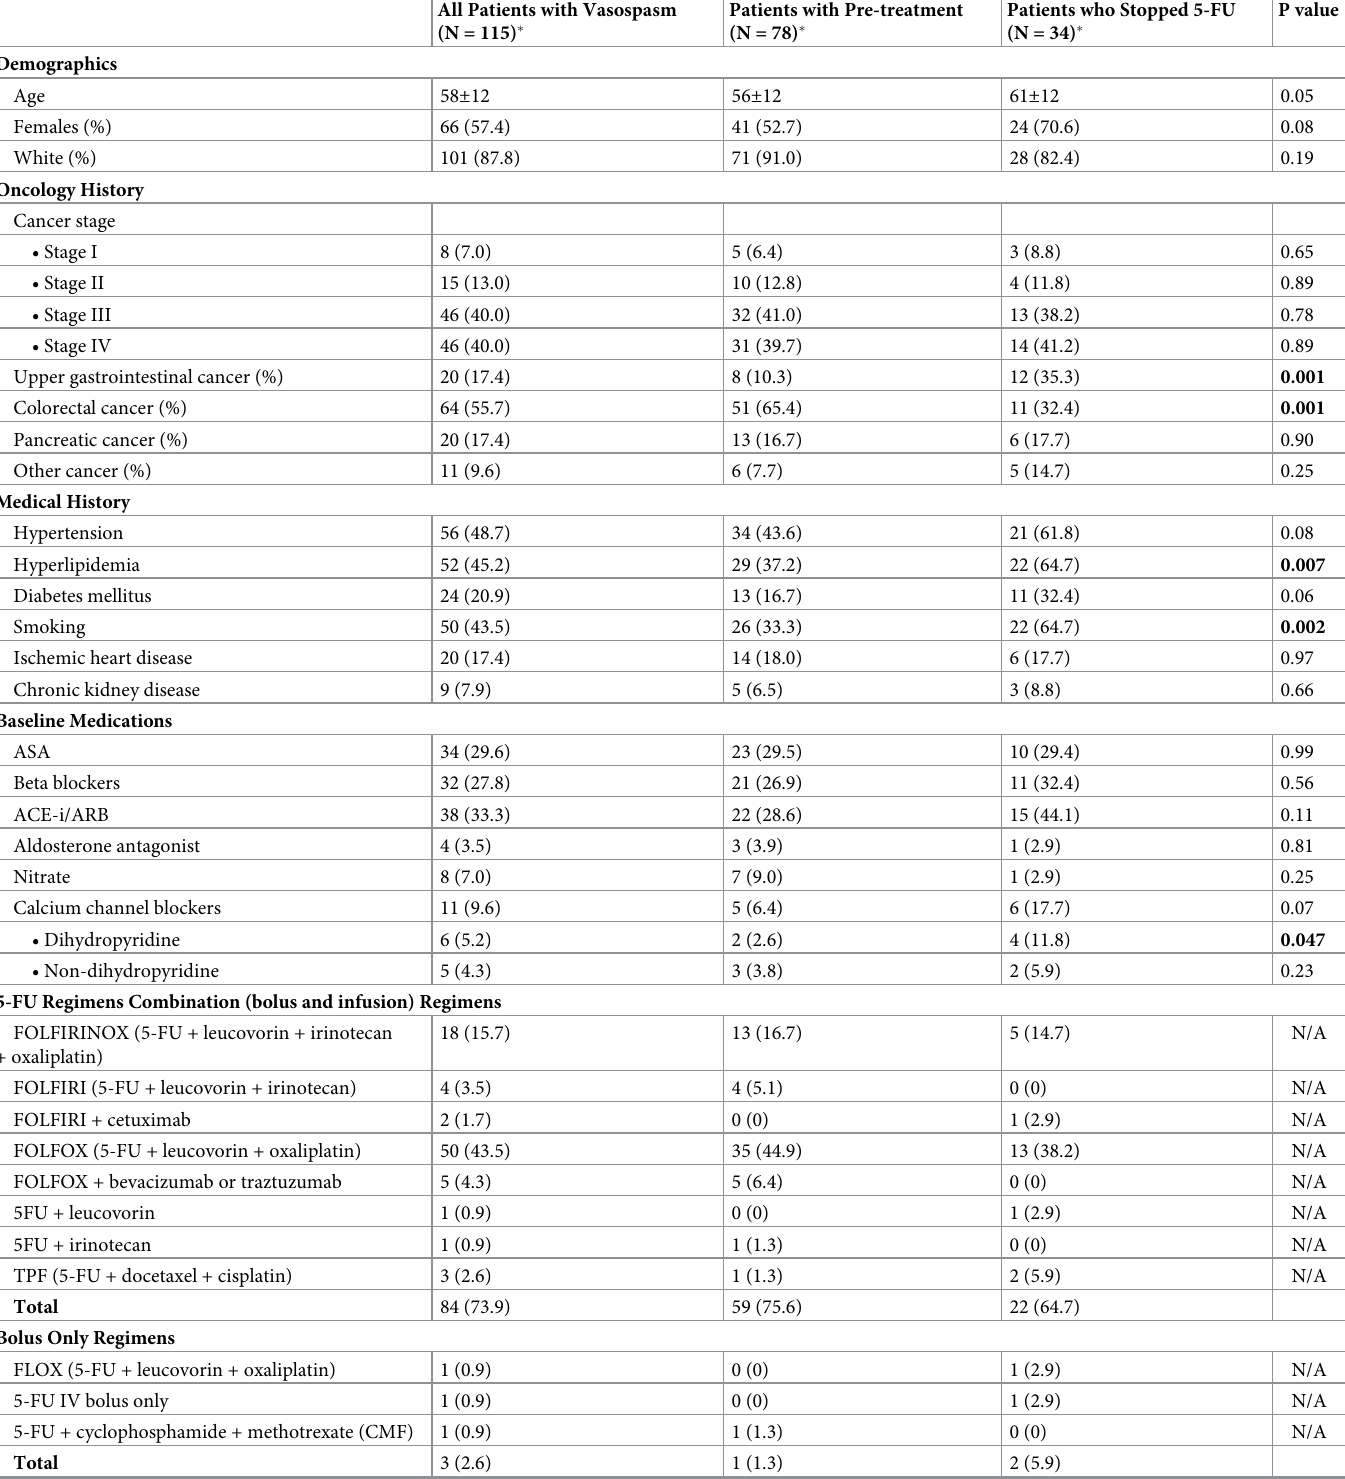
Table 1. Baseline characteristics of all patients with vasospasm, and comparison of those of who continued 5-FU therapy with cardiac pre-treatment vs. those who stopped 5-FU